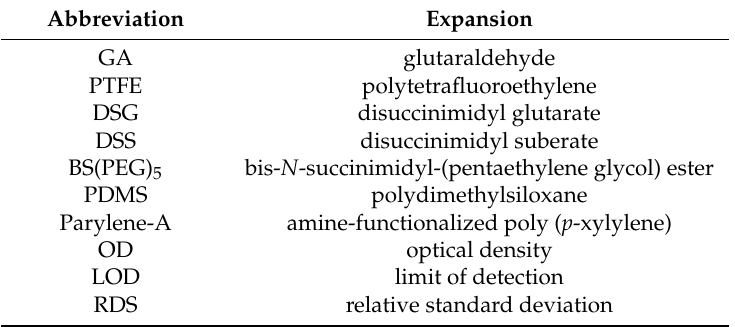
Table 1. Abbreviations used in this